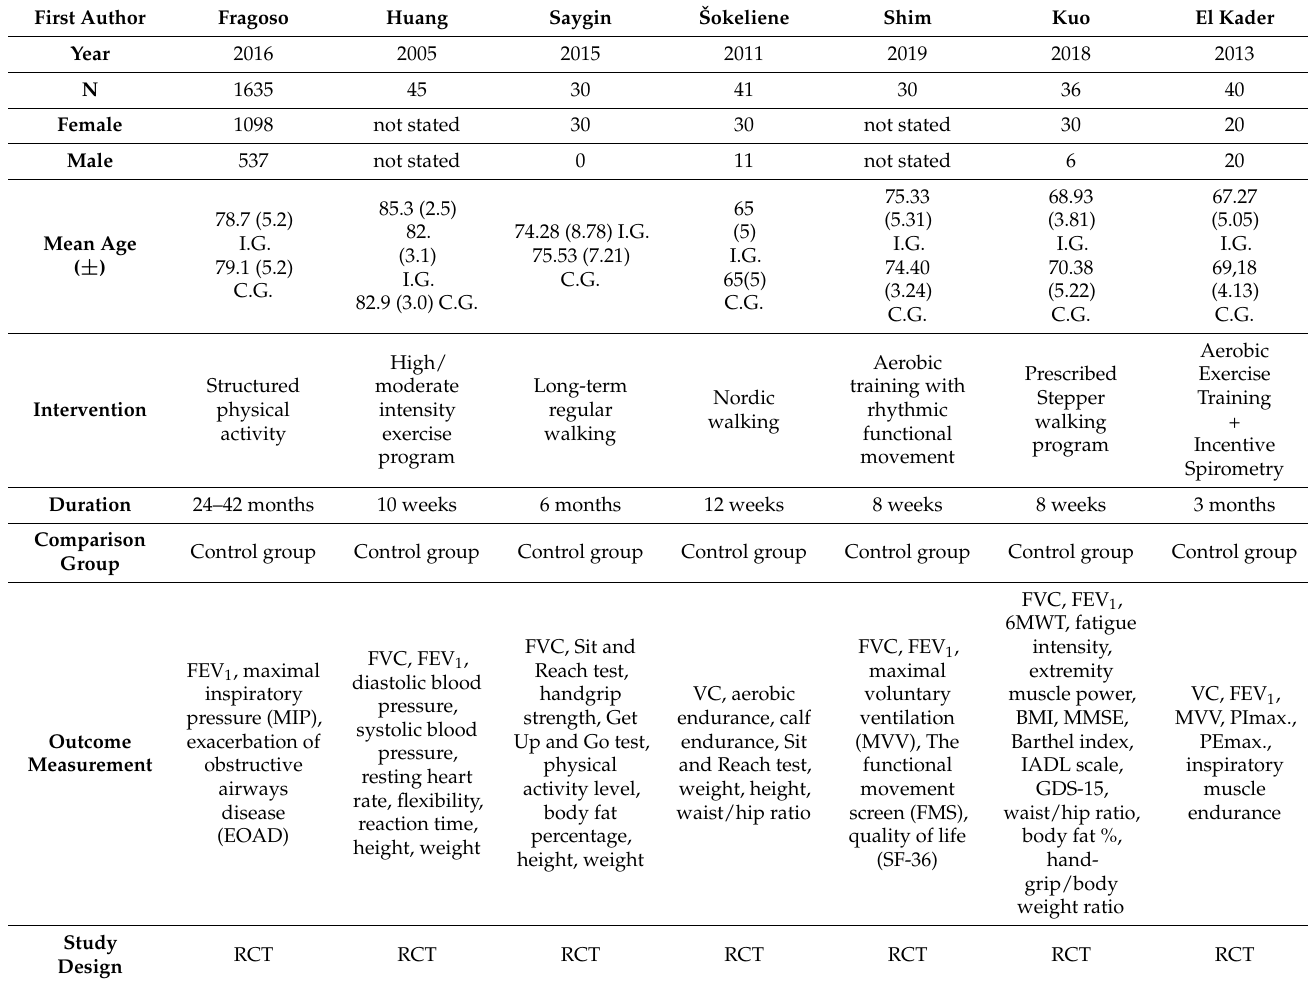
Table 4. Main characteristics of included